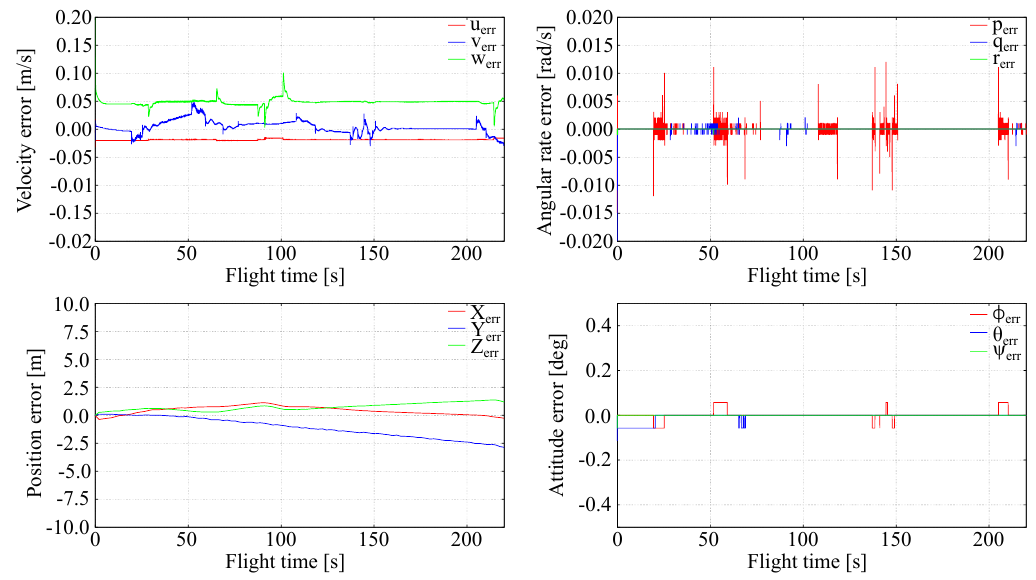
Figure 5. Full tracking errors, quiet atmosphere.